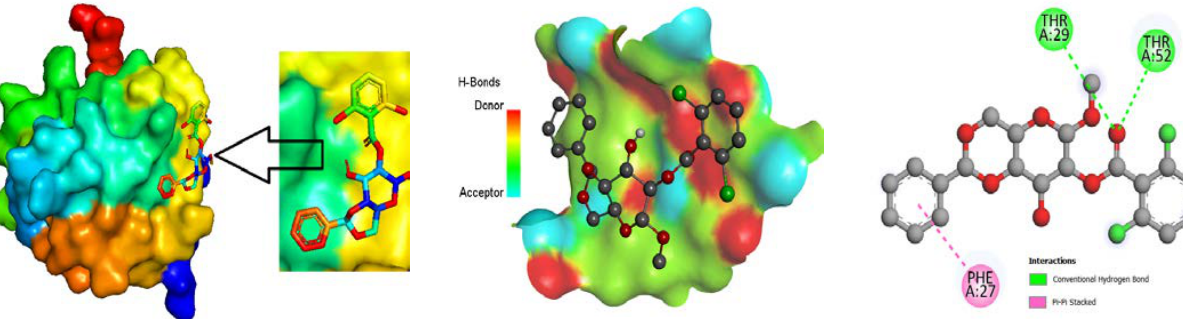
Figure 5. Molecular docking poses of white spot syndrome virus (PDB 2EDM) with L01.